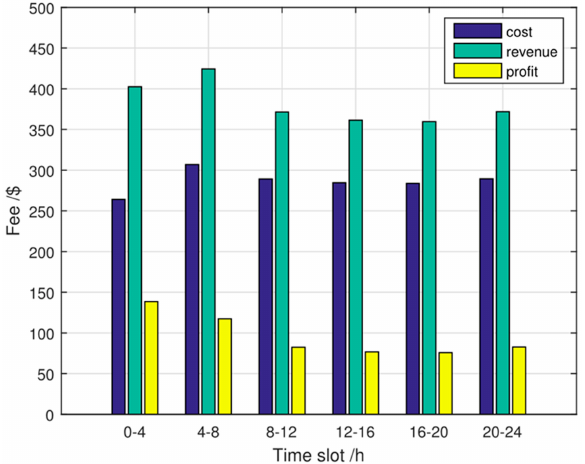
Figure 4. The aggregator’s cost, income and profit.